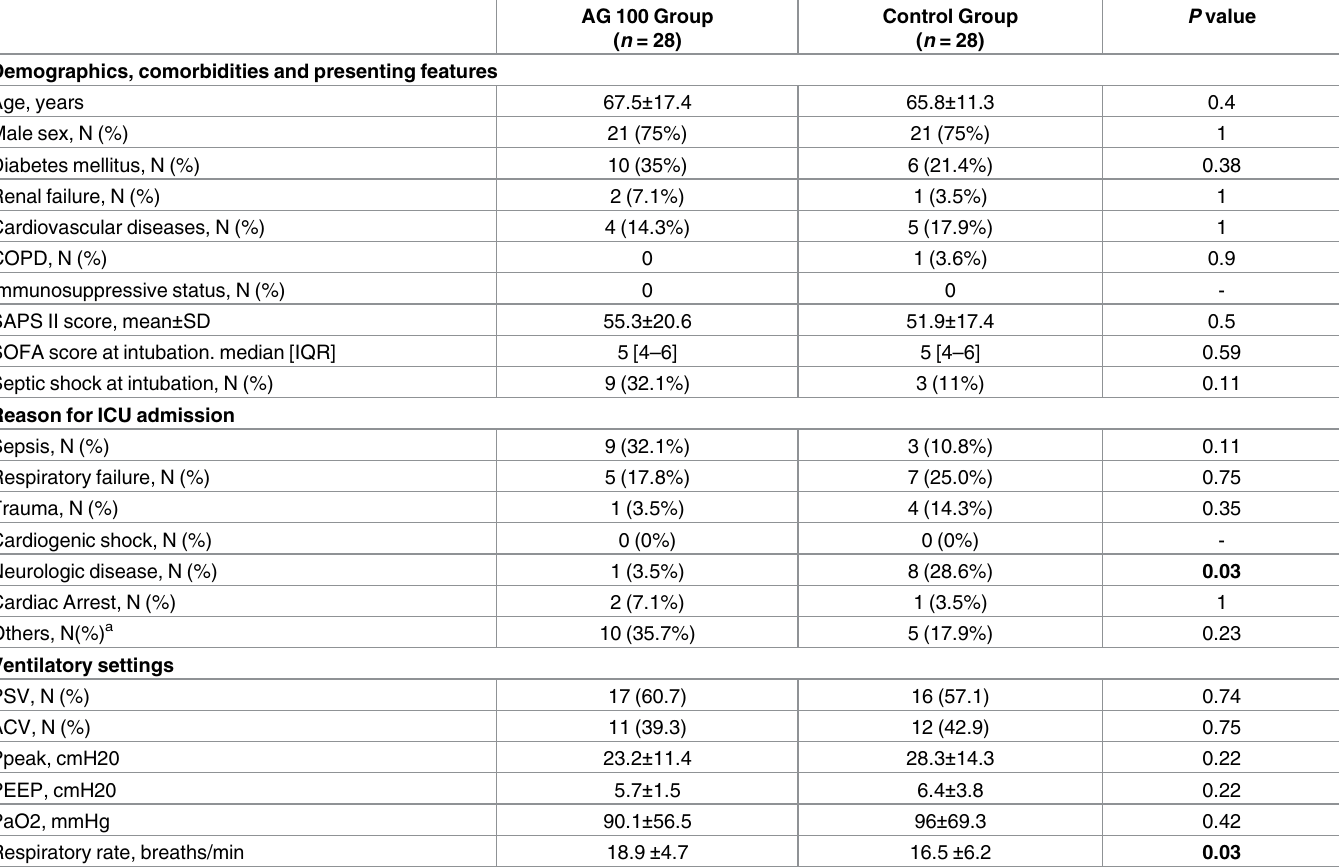
Table 1. Baseline patient